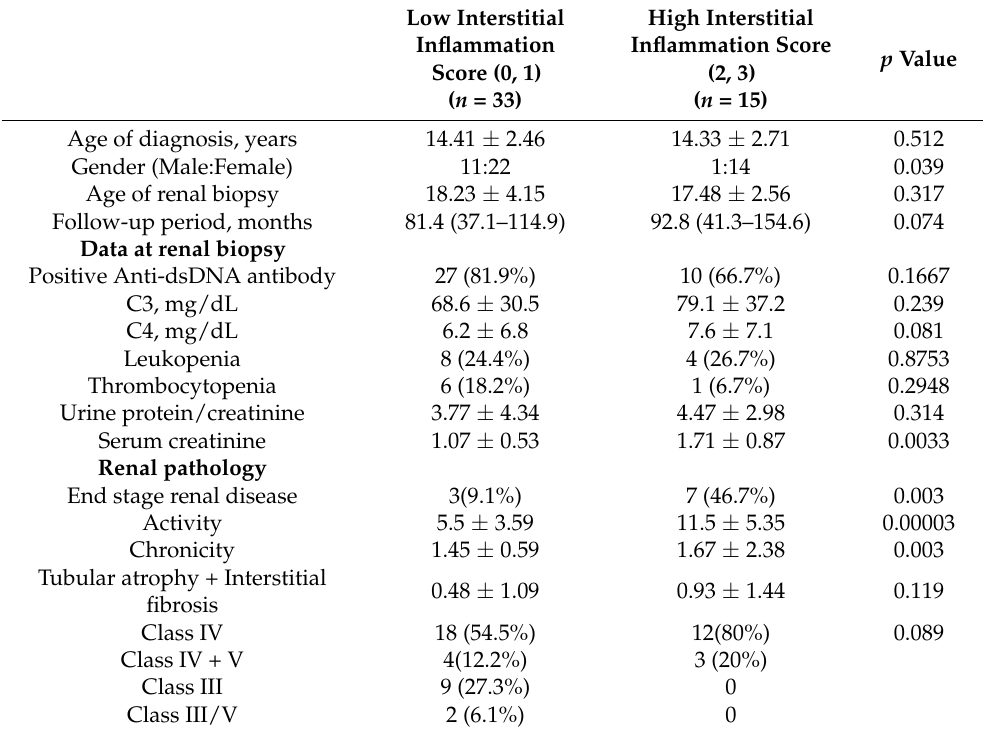
Table 1. Basic profile, serological, laboratory and pathology data in low and high interstitial inflam- mation scores groups.